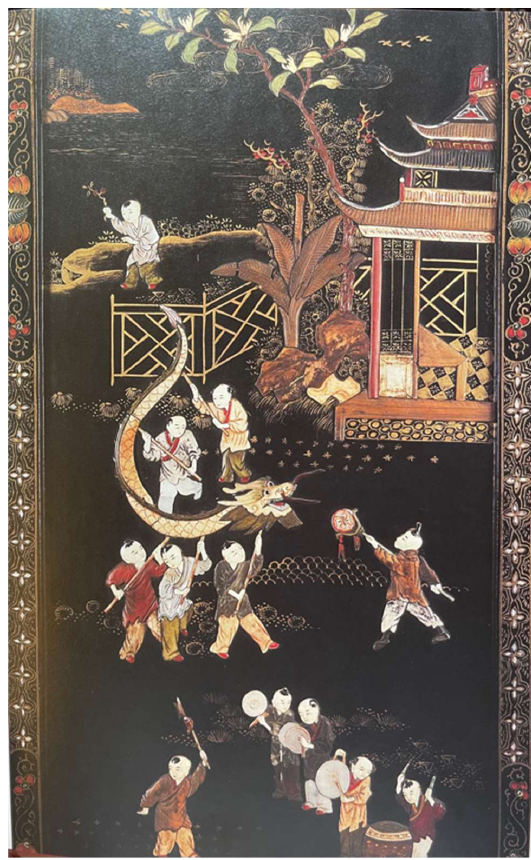
Figure 8. Children taking part in a dragon parade, part of an inlaid lacquer screen in the collection of Dr. Lu Guizhen 魯 桂 珍 (1904–1991), a co-author of Joseph Needham’s Science and Civilisation in China and the second wife of Needham.